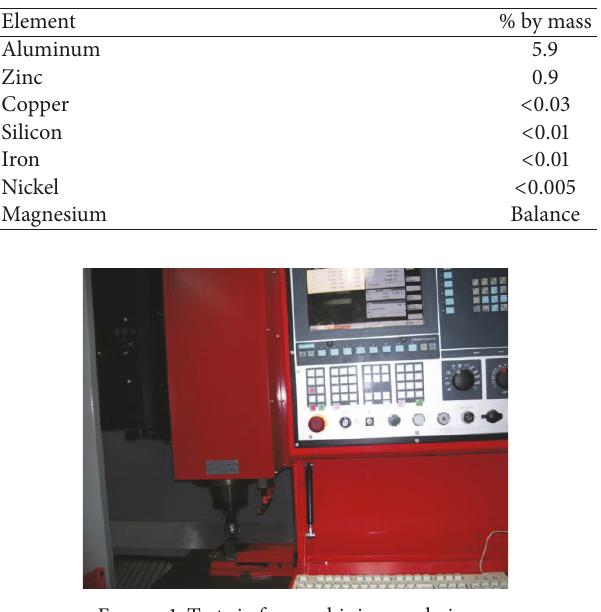
Figure 1: Test rig for machining workpieces.